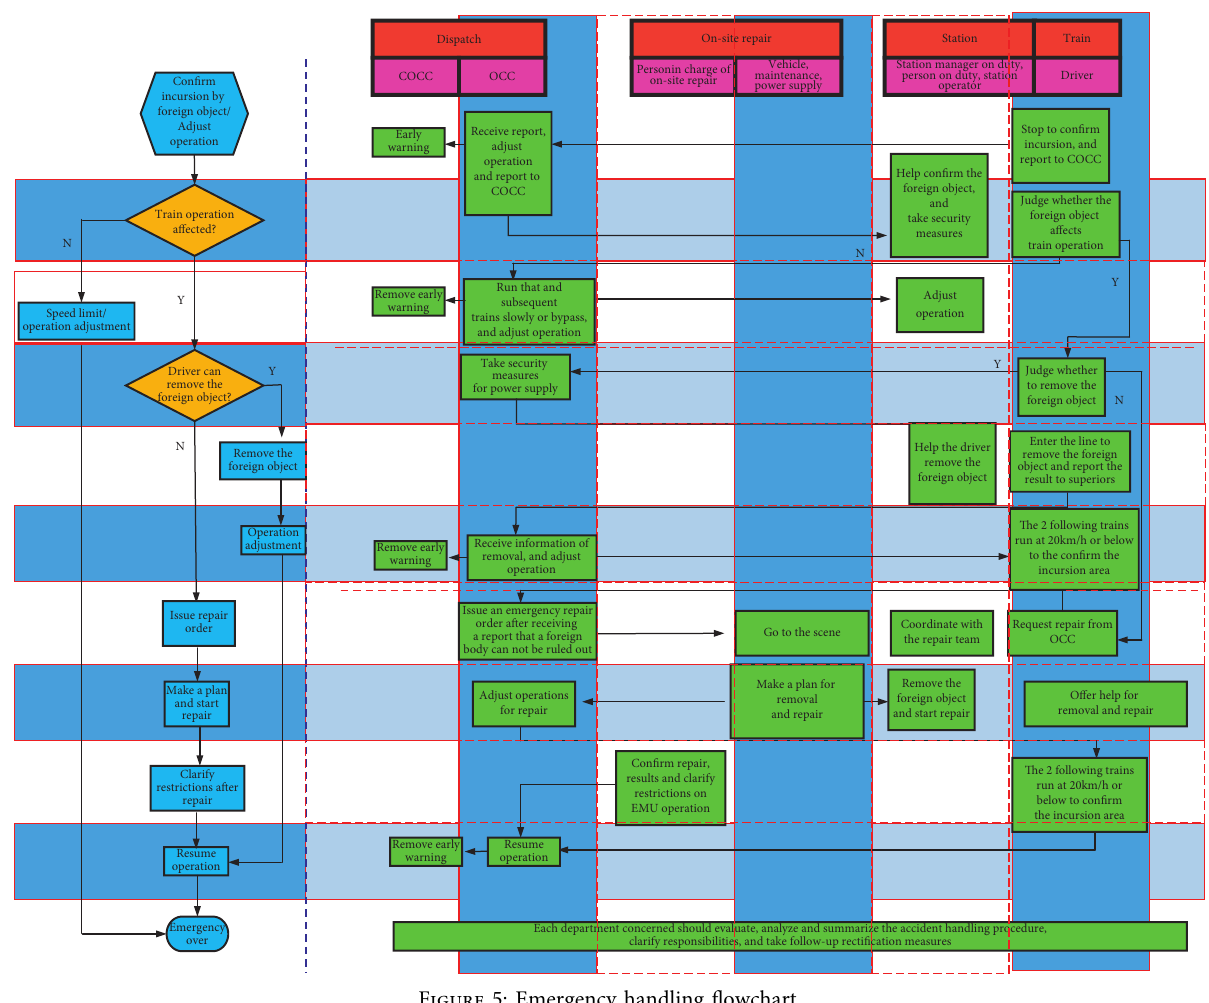
Figure 5: Emergency handling